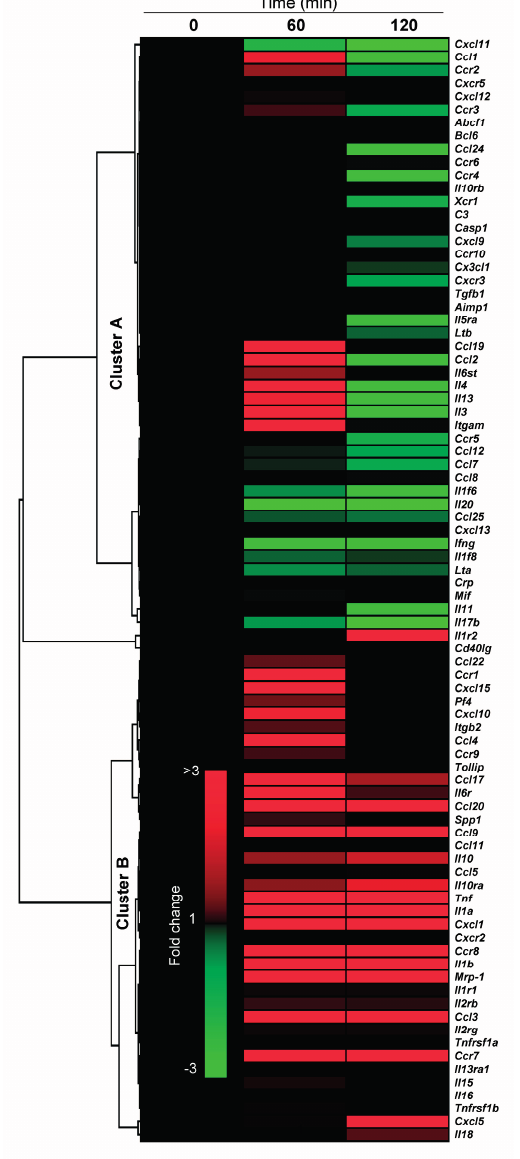
Figure 4. Changes in pro-inflammatory gene expression induced by 8-oxoG, the product of OGG1-BER. Mice were challenged i.n. with 8-oxoG base (50 ng per kg), and RNA was extracted. Total RNA (pooled from five mice) was reverse-transcribed into cDNA and analyzed using a Mouse Inflammatory Cytokines & Receptors PCR Array (Cat # PAMM-011A, SABiosciences, Valencia, CA, USA). Data were analyzed using RT 2 profiler PCR data analysis template version 2.0. Heat maps were created and unsupervised hierarchical clusters were constructed using GENE-E online software (Broad Institute; Cambridge, MA, USA). Genes were clustered using Spearman’s rank correlation coefficient [108]. The colors in the heat-map show the minimum and maximum values (±3). Animal experiments were performed as described in the legend to Figure